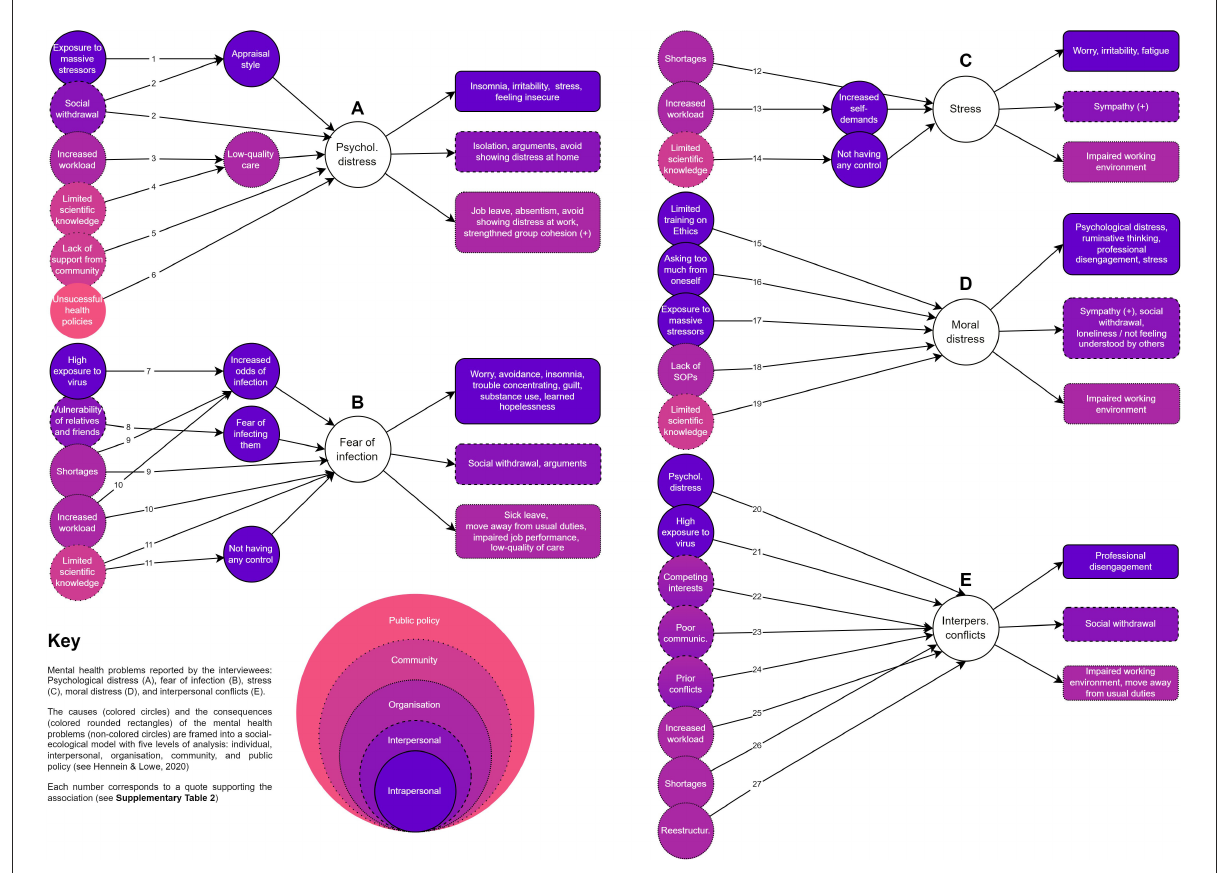
FIGURE1 Multi-level, subjective causal models of the five mental health problems, as perceived by KI interviewees.